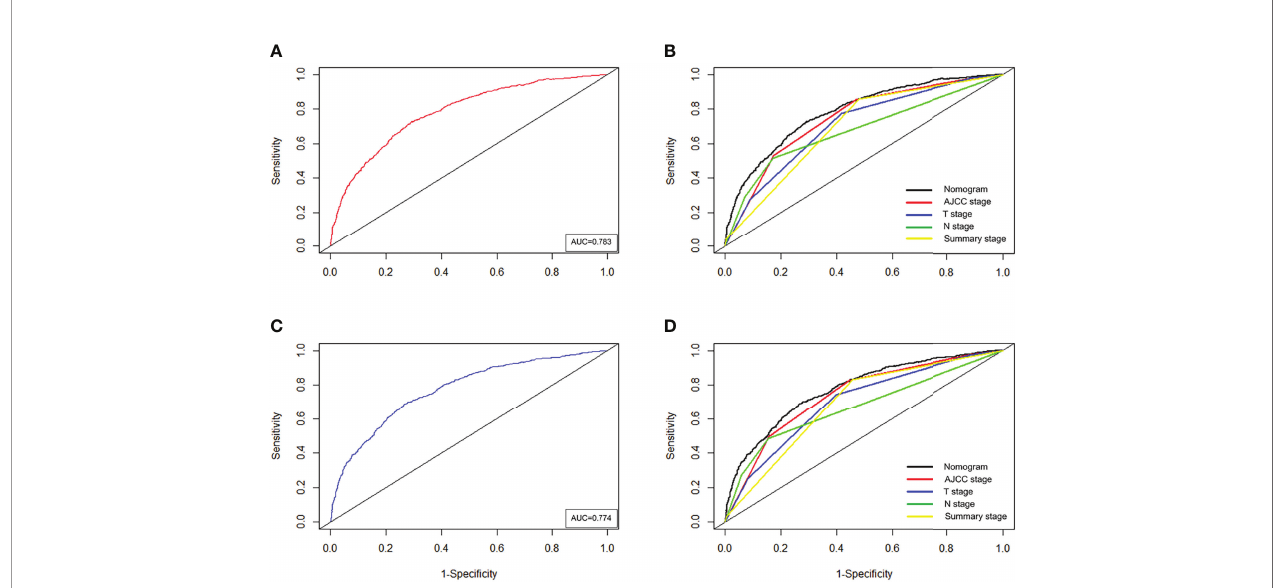
FIGURE 3 | Time-dependent ROC curves of the nomogram predicting 3-years (A) , and 5-years (C) CSS in the primary cohort. Comparison of the ROC curves between nomogram and other independent factors at the 3-years (B) , and 5-years (D) CSS in the primary cohort.